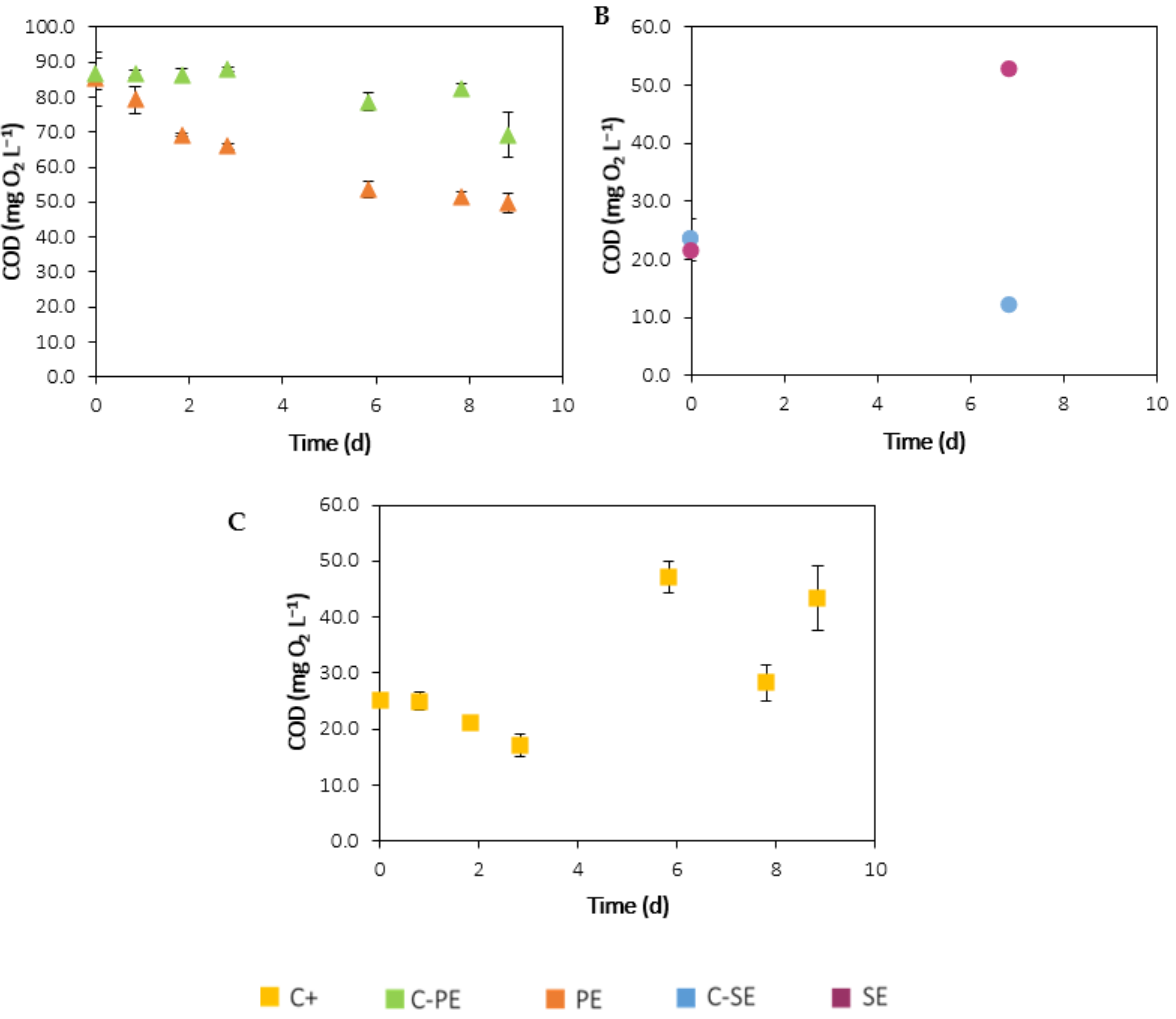
Figure 5. Time-course evolution of COD in assays with C-PE/PE ( A ), C-SE/SE ( B ), and C+ ( C ). Error bars correspond to the standard deviation of the mean obtained from two independent experiments.